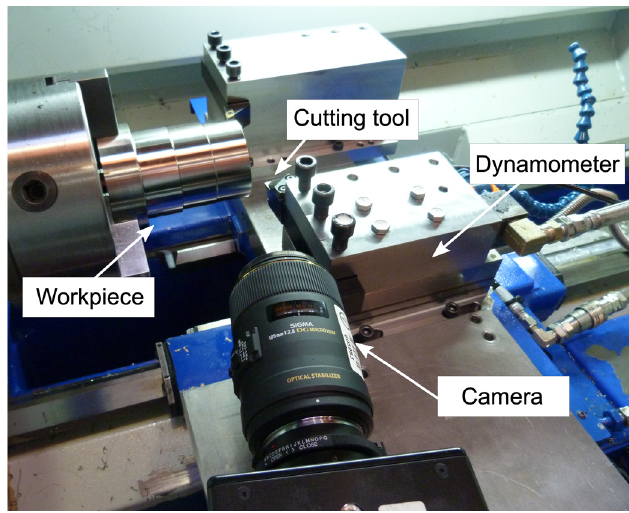
Figure 1. Experimental setup for the tests.